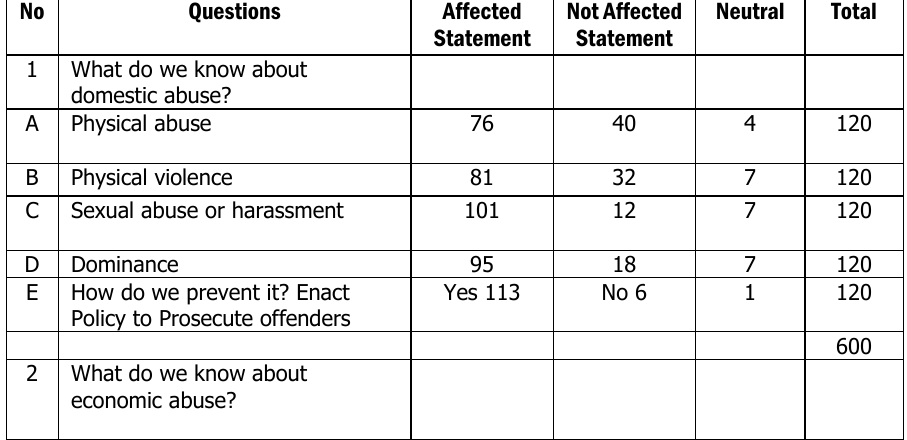
Table 8: Sample Focus Group Questions and